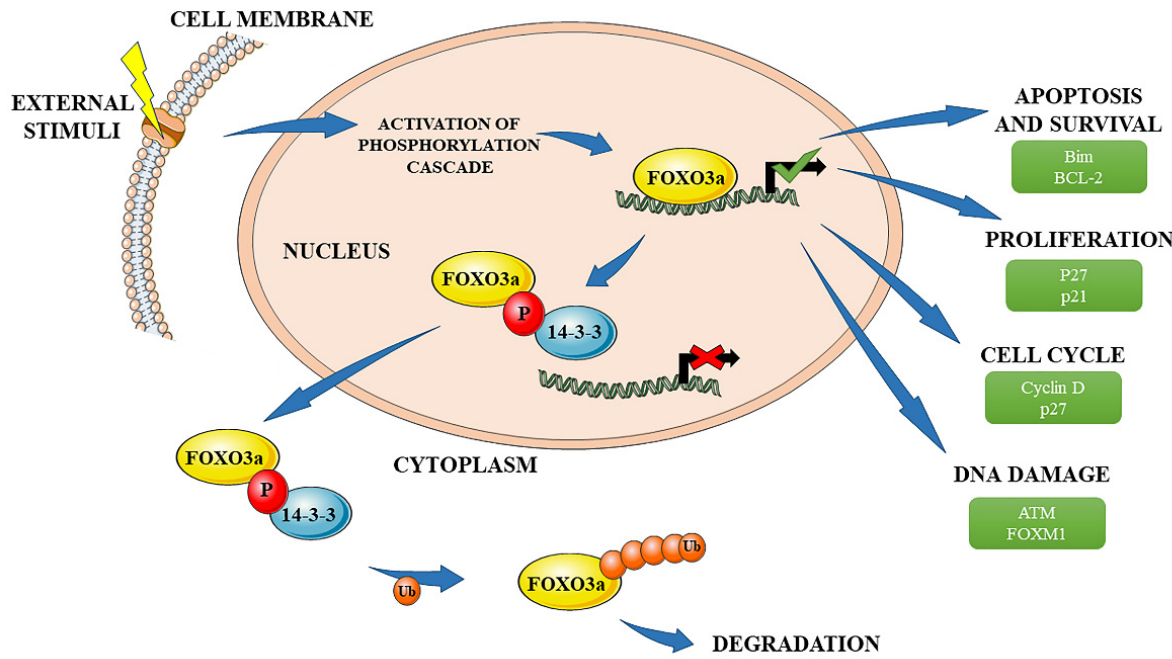
Figure 2. Schematic diagram showing the activity of FOXO3a transcription factor and its role in cells with examples of genes associated with particular processes. The graphical illustration was prepared by using the images from Servier Medical Art by Servier (https://smart.servier.com/smart_image/, accessed on 10 November 2021 ).